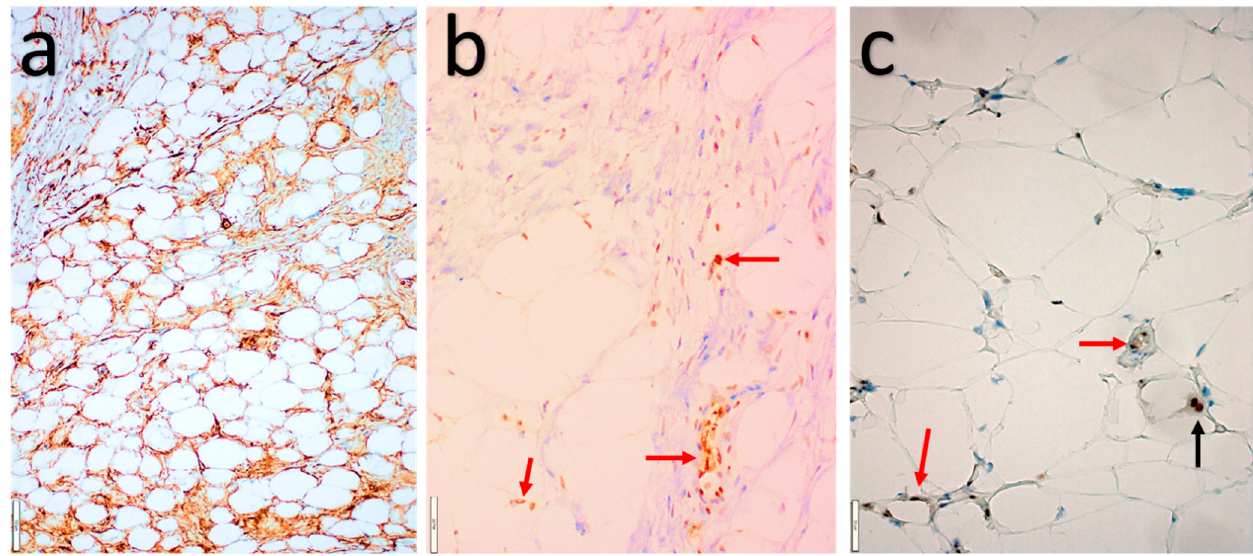
Figure 4. Atypical spindle cell/pleomorphic lipomatous tumor. ( a ) Strong, diffuse, cytoplasmatic CD34 expression. ( b , c ) Loss of nuclear Rb expression in the adipocytes and spindle cells, and intact nuclear Rb expression in the endothelial cells (red arrows) and macrophage (black arrow).